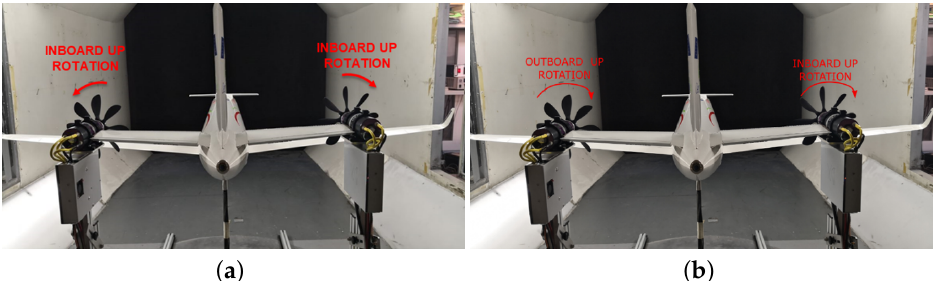
Figure 11. Considered propeller rotation for the power-on experimental tests: ( a ) contra-rotating Inboard-Up (IU) propellers rotation; ( b ) co-rotating (CR) propellers